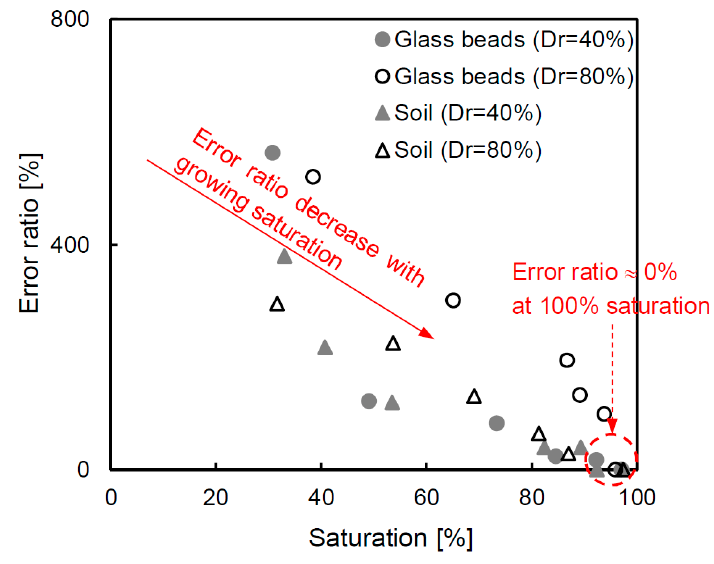
Figure 11. The error ratio based on the porosity when using the cementation factor, deduced by the Archie equation, and assuming a fully saturated condition.